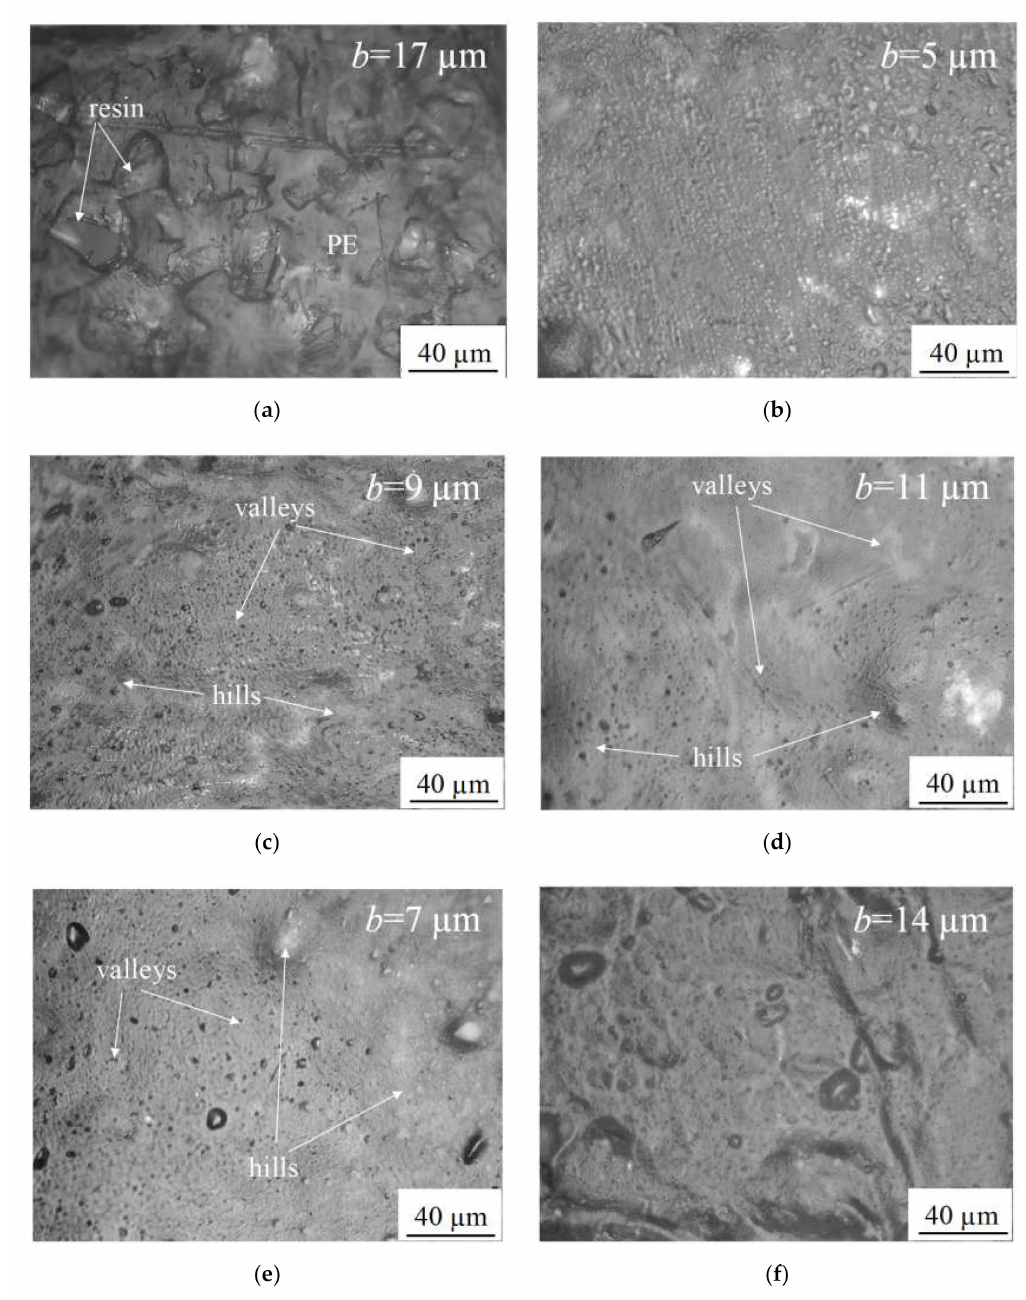
Figure2. Opticalimagesofthestudiedmembranes: MK-40( a ), MK-40 21 ( b ), MK-40 21 + 3% ( c ),MK-40 21 + 6% ( d ), MK-40 33 + 3% ( e ), MK-40 33 + 6% ( f ). Parameter b characterizes the roughness of the surface and shows the difference between the highest and lowest areas of the membrane